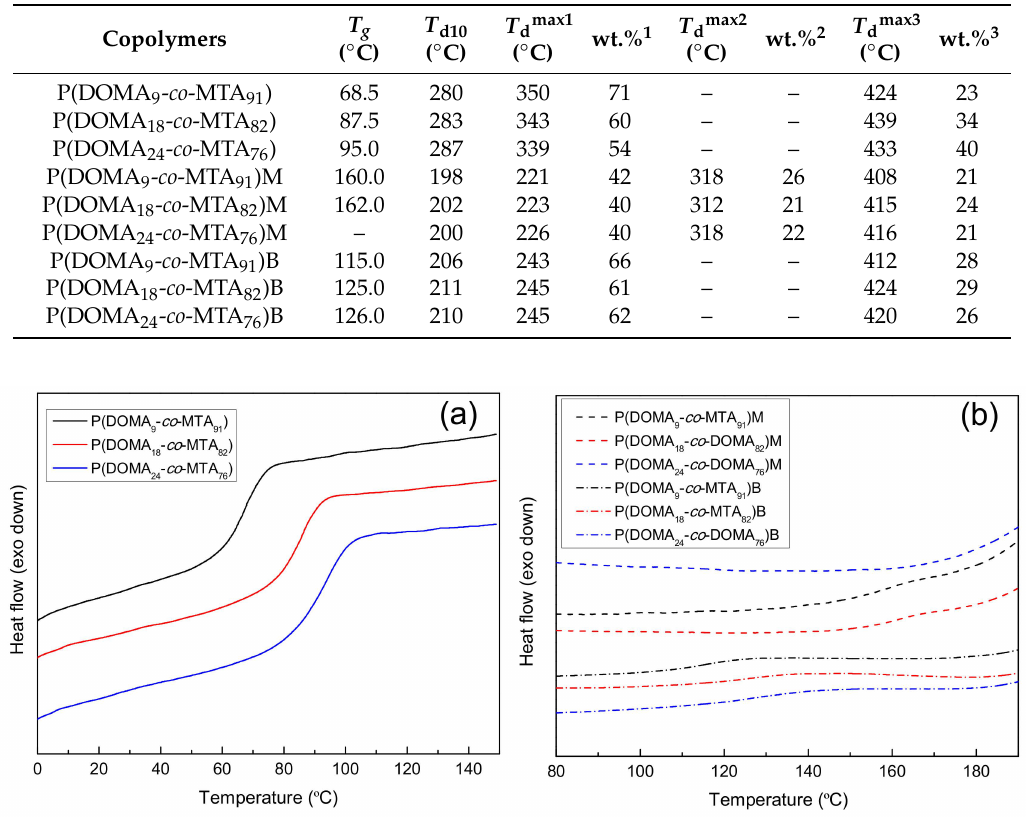
Table 1. Compositions and thermal parameters of the synthesized copolymers, glass transition temperature ( T g ), decomposition temperatures at 10% weight loss ( T d10 ), temperatures of the maximum rate of weight loss for each step ( T dmax1 , T dmax2 , and T dmax3 ) and weight loss for each step (wt.% 1 , wt.% 2 , wt.% 3 ).